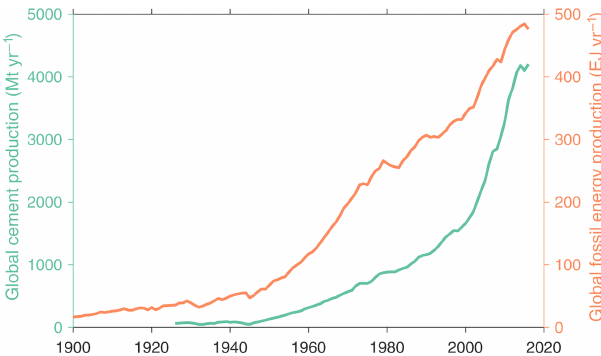
Figure 1. Global cement and fossil energy production to 2016 (USGS, 2014; Mohr et al.,